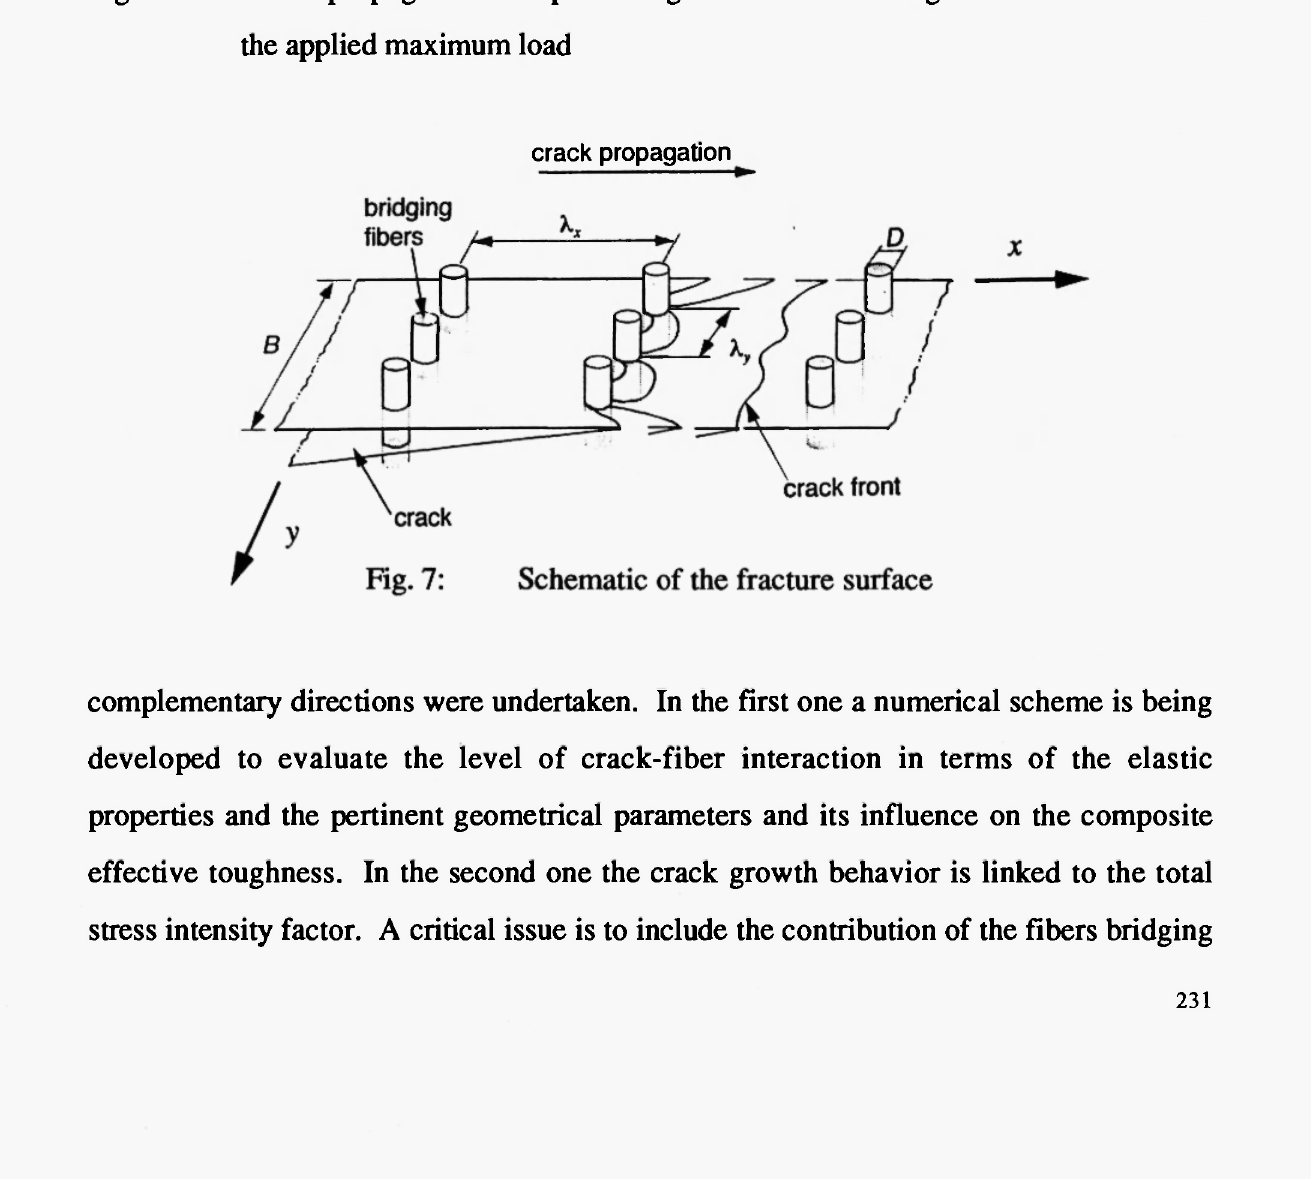
Fig. 6: Crack propagation rate plotted against the crack length for three levels of the applied maximum load